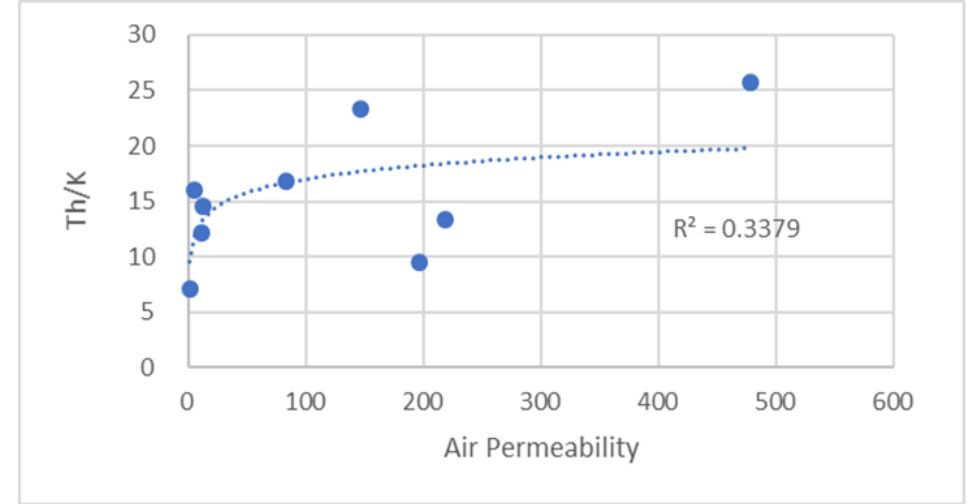
Figure 26. A scatter plot showing the relations of mud grain size percentage and air permeability.